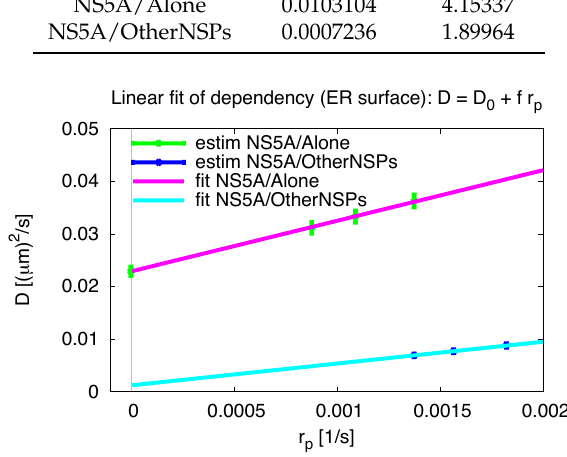
Figure A4. Dependency diffusion constant of NS5A on ER surface on pseudo reaction constant, linear fit of (A1) for numerical stability test reasons. “estim”: estimated values, “fit”: linear fit.